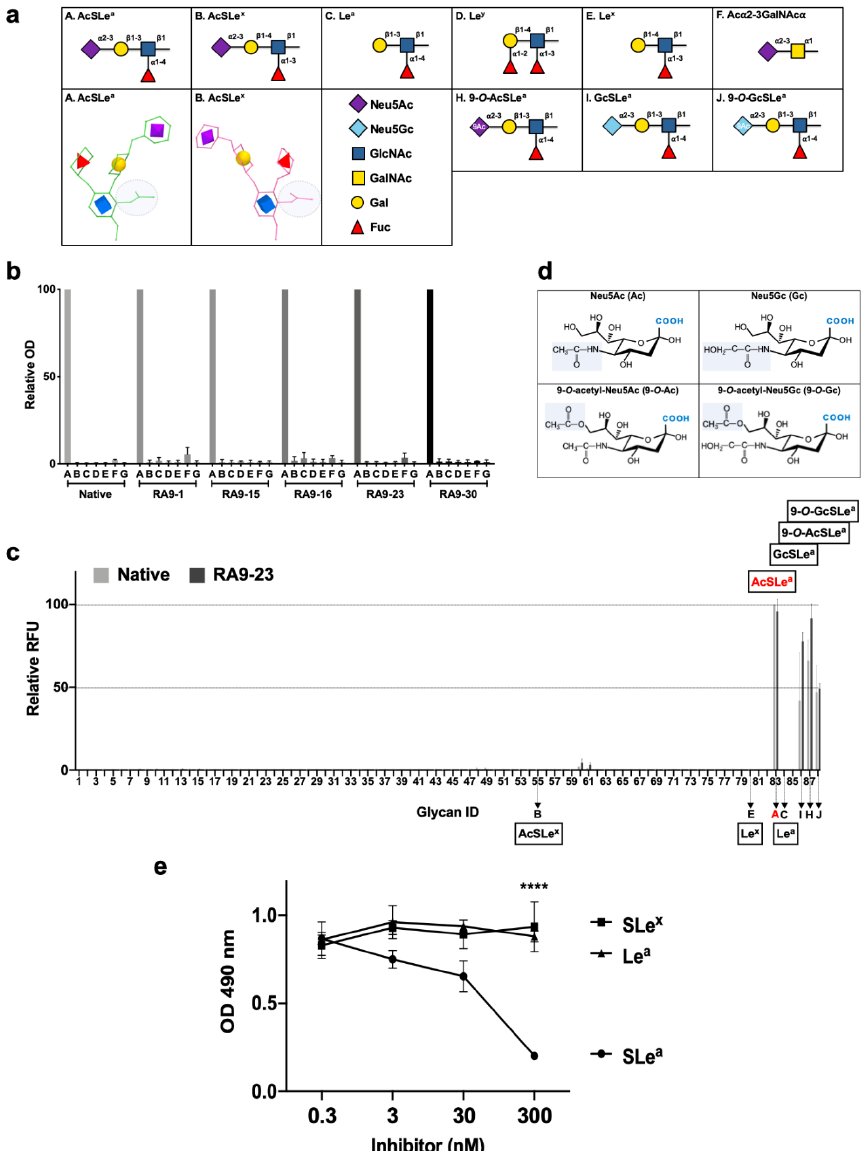
Figure 4. Cloned antibodies specificity against multiple glycan antigens. ( a ) Structures of SLe a and closely-related glycans. In AcSLe a (A), the N -acetyl group on GlcNAc (shaded grey circle) is oriented to the same side as the sialic acid (purple diamond), while in opposite directions in the AcSLe x (B) isomer. ( b ) Specificity of native and RA9-mutated clones expressed as full-length IgG were examined by ELISA. 96-well plate was coated with PAA-polymer conjugated glycans, and primary antibodies examined at 10 ng / µ L. Relative optical density (OD) was calculated as percentage of maximal binding of each antibody clone, followed by averaging the relative rank of two independent experiments (mean ± SEM). Glycans labeled A–F correspond to the structures described in ( a ), G is polyacrylamide backbone (PAA) control. ( c ) Binding of native and RA9-23 IgGs against diverse glycans was examined at 0.16, 0.08 and 0.032 ng / µ L by a sialoglycan microarray (List of glycans in Table S1). Relative fluorescence units (RFU) was calculated as percentage of maximal binding at each concentration, followed by averaging the relative RFU rank of the three tested antibody concentrations for each glycan (mean ± SEM). A–C, E, H–J correspond to the structures described in ( a ). ( d ) Chemical structures of sialic acid types Neu5Ac (Ac), Neu5Gc (Gc), 9- O -acetyl-Neu5Ac (9- O -Ac), and 9- O -acetyl-Neu5Gc (9- O -Gc). ( e ) Specificity of the full-length antibody mutant clone RA9-23 was examined by ELISA inhibition assay against coated SLe a -PAA-Biotin, after pre-incubation of the antibody with specific (SLe a ) or non-specific glycans (SLe x and Le a ). **** p <